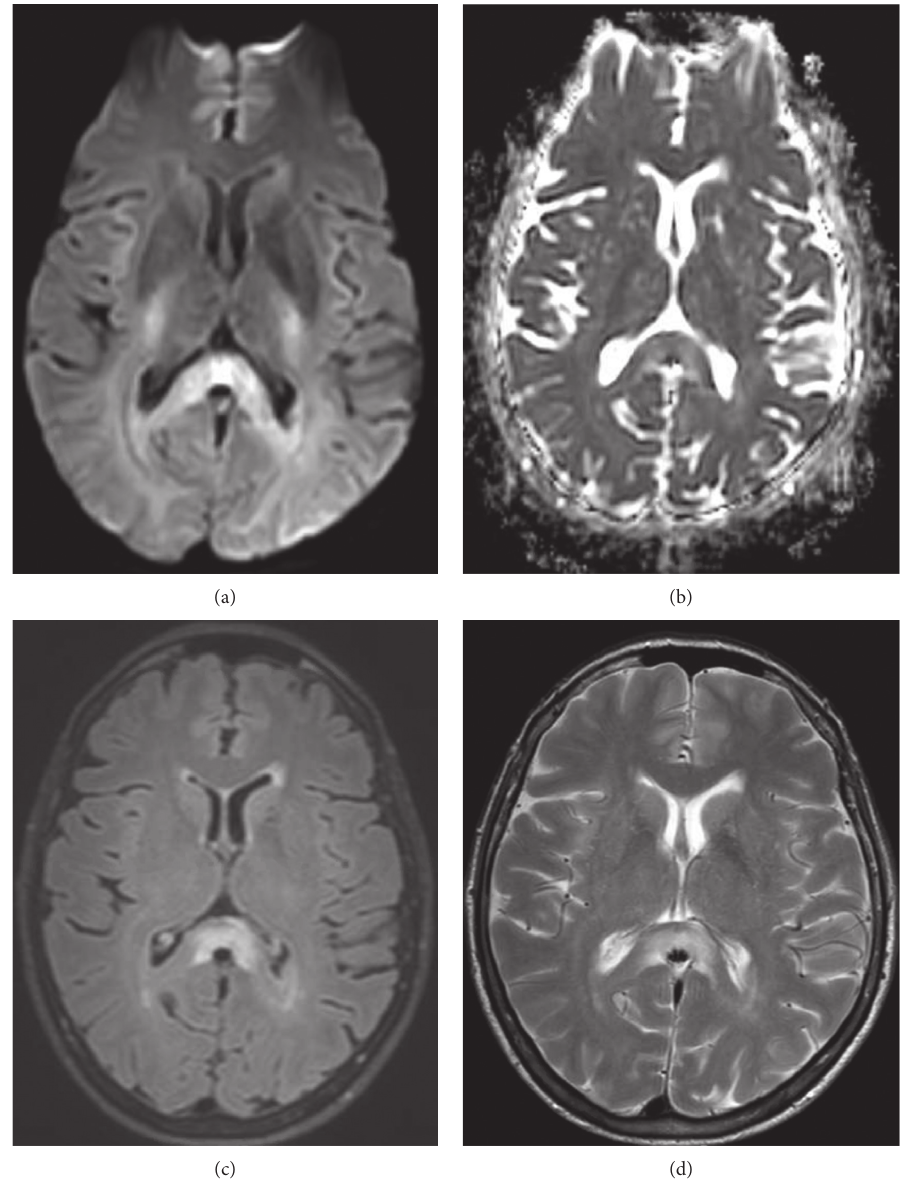
Figure 2: MR brain with and without contrast at one month follow up. (a) DWI, axial cut. (b) ADC axial cut. (c) FLAIR axial cut. (d) T2 axial cut. In comparison, the corpus callosum lesion is stable compared to prior imaging with the absence of novel interval